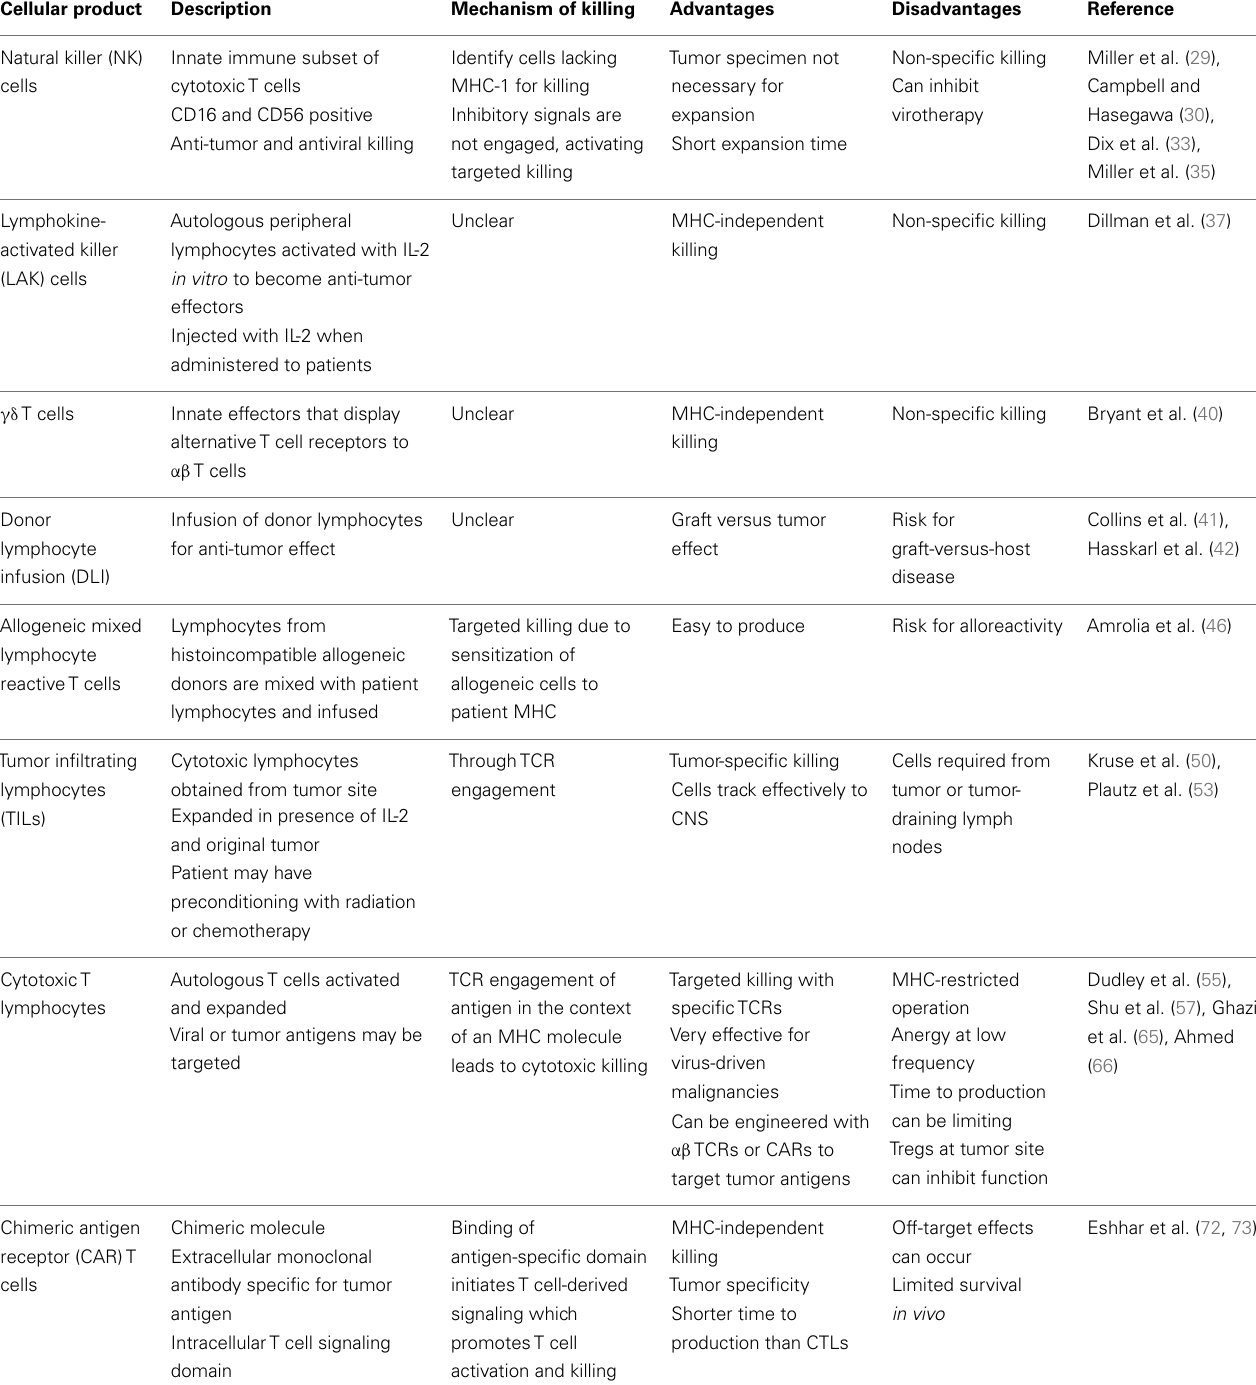
Table 1 | Modalities of cellular therapies for